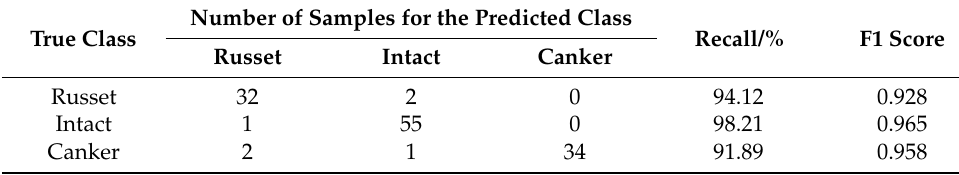
Table 6. Results of testing set based on detection